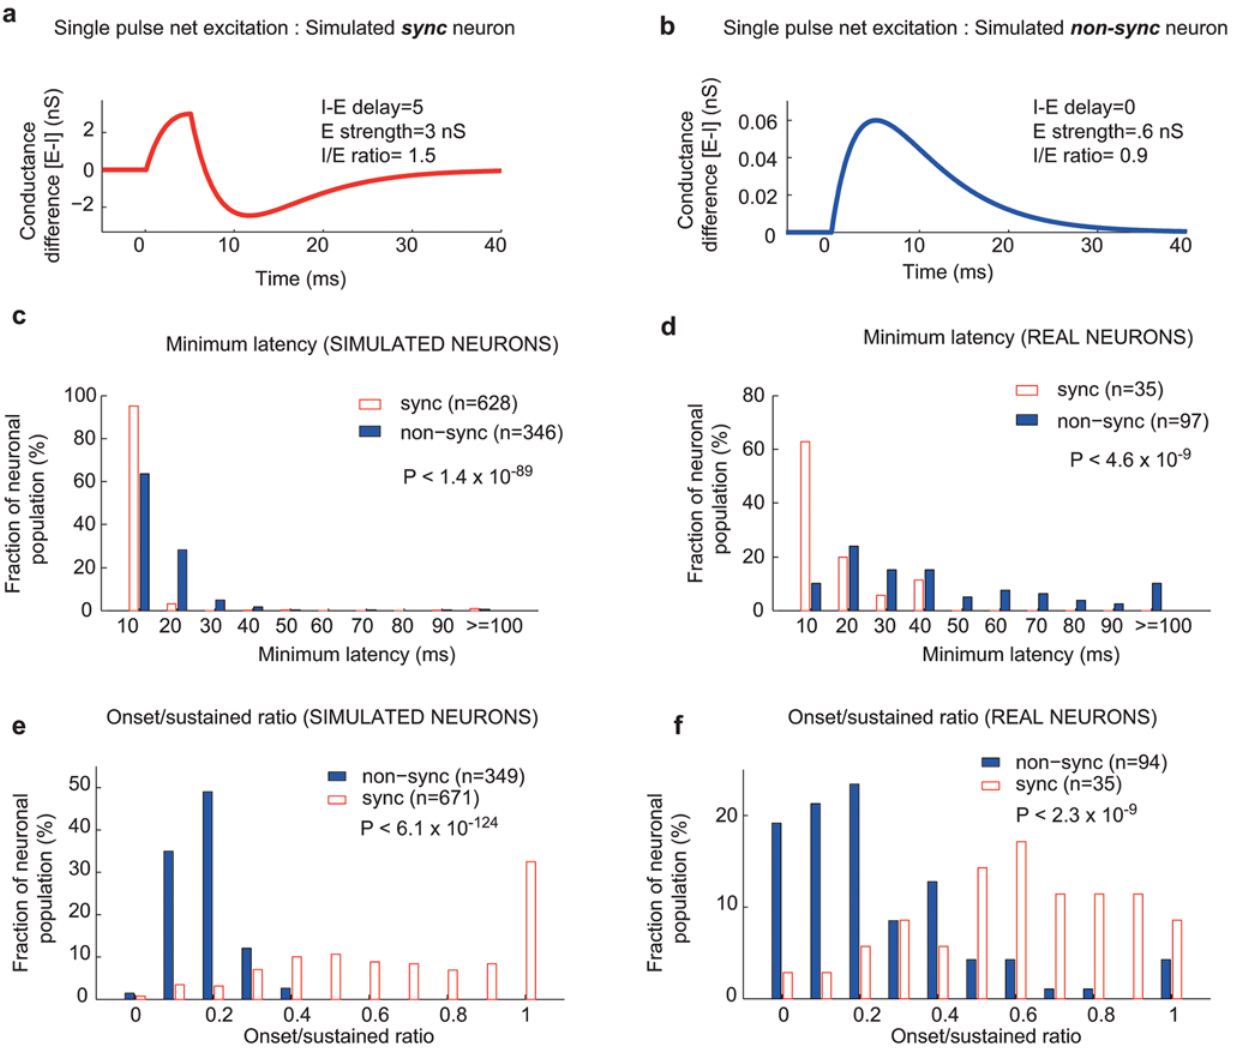
Fig 6. Temporal dynamics of synchronized and non-synchronized neurons. a. Net excitation (excitatory-inhibitory conductance) for a single acoustic pulse in a simulated synchronized neuron. I-E delay = 5 ms, E strength = 3 nS, I/E ratio = 1.5. b. Net excitation (excitatory-inhibitory conductance) for a single acoustic pulse in a simulated non-synchronized neuron. I-E delay = 0 ms, E strength = 0.6 nS, I/E ratio = 0.9. c. Minimum latency distribution for acoustic pulse train responses in simulated neurons. Mean: sync = 10.8 ms, nonsync = 16.6 ms, Wilcoxon rank sum test: P < 1.4 x 10 -89 . d. Minimum latency distribution for acoustic pulse train responses in real neurons. Mean: sync = 18.1 ms, nonsync = 51.1 ms, Wilcoxon rank sum test: P < 4.6 x 10 -9 . e. Onset/ sustained ratio distribution for pure tone responses in simulated neurons. Mean: sync = 0.69, nonsync = 0.18, Wilcoxon rank sum test: P < 6.1 x 10 -124 . f. Onset/sustained ratio distribution for pure tone responses in real neurons. Mean: sync = 0.60, nonsync = 0.25, Wilcoxon rank sum test: P < 2.3 x 10 -9 .